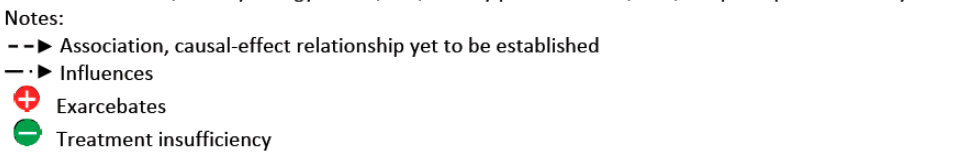
Figure 1. Etiology of malnutrition in dialysis patients.